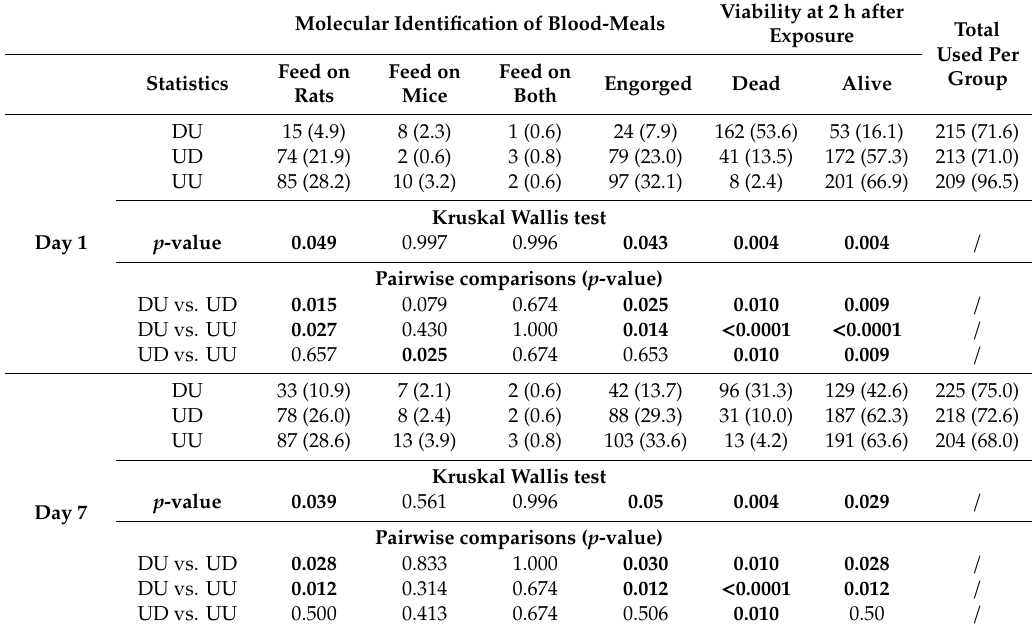
Table 2. Statistical analysis of engorgement status, blood-meal origin, and mosquito viability between the three